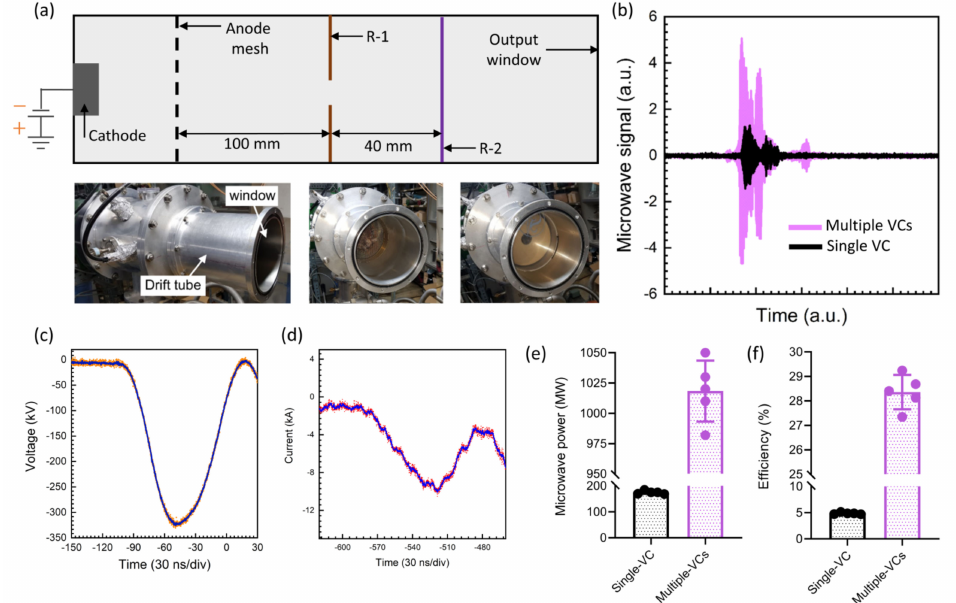
Figure 7. The experimental results and comparison of single and multiple VCs. ( a ) The experimental arrangement with two reflectors. ( b ) Photographs of the waveguide without and with reflectors inside. ( b ) The real microwave signal with single VC and with multiple VCs, ( c ) diode voltage with maximum of 343 kV, ( d ) diode current 10.52 kA, ( e ) microwave power, and ( f ) efficiency of the VCO with a single VC and with multiple